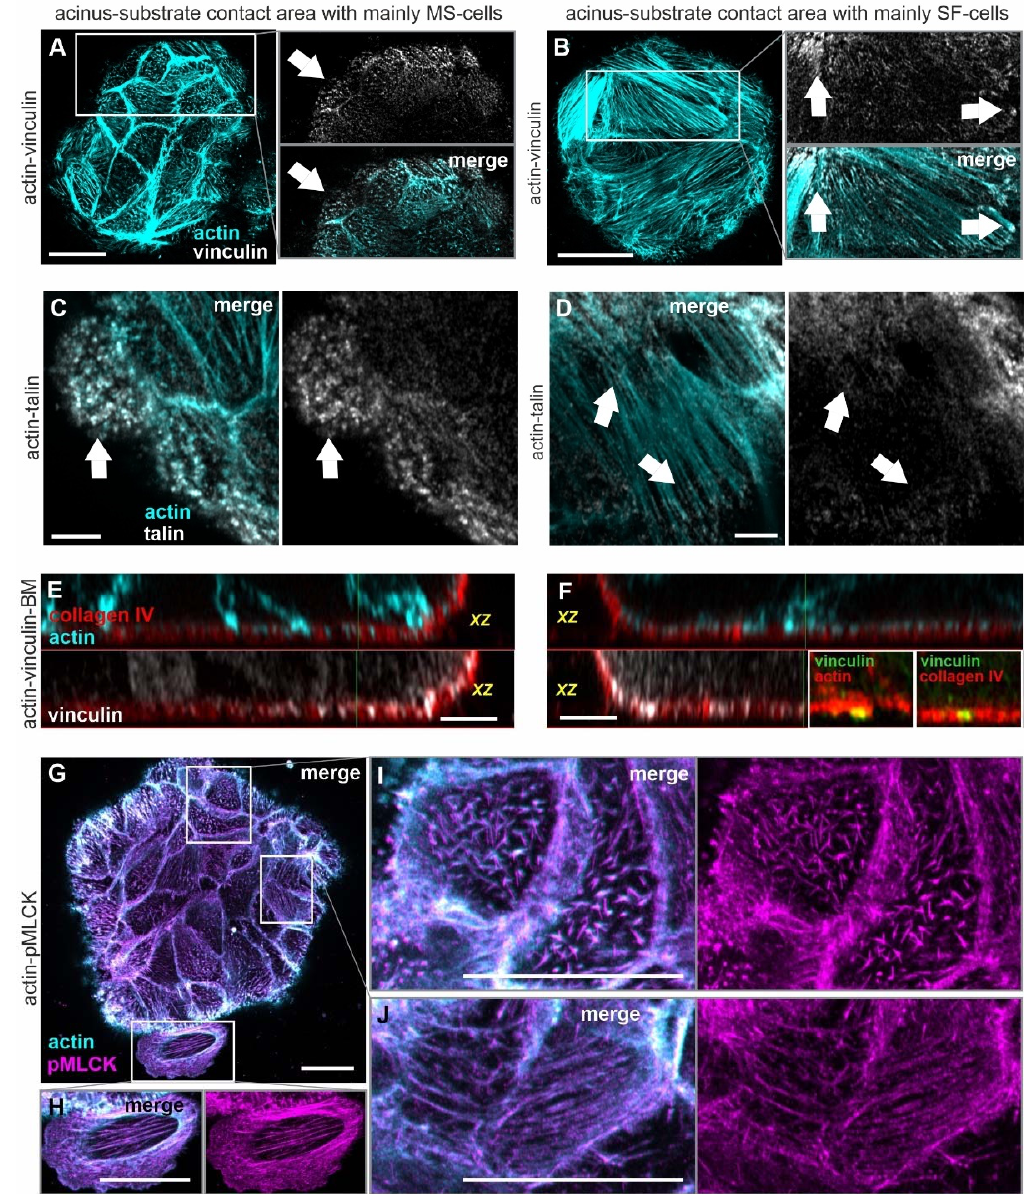
Figure 6. Focal adhesion-mediated actomyosin activation in MS and SF cells. MCF10A acini were fixed and IF-stained. ( A – D ): Representative confocal images of the acinus–BM–substrate interface. ( A , C ) MS cells (1h on glass, − EGF) and ( B , D ) SF cells (24 h on glass, +EGF) show the co-localization of actin microspikes and stress fiber ends with vinculin and talin